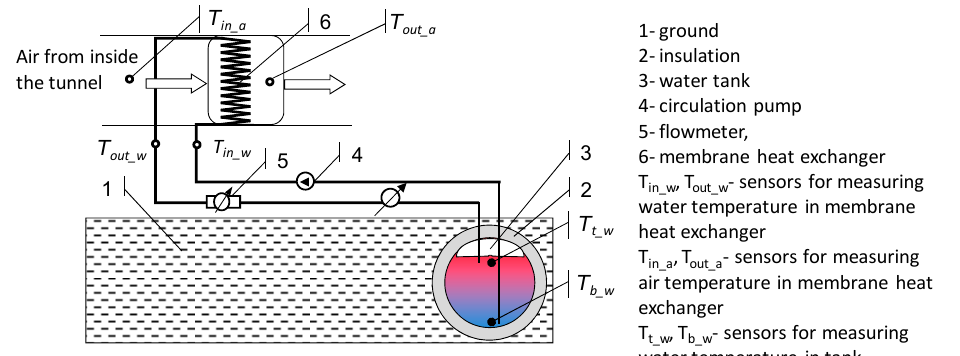
Figure 4. Diagram of the stand for measuring the efficiency of the water accumulator.